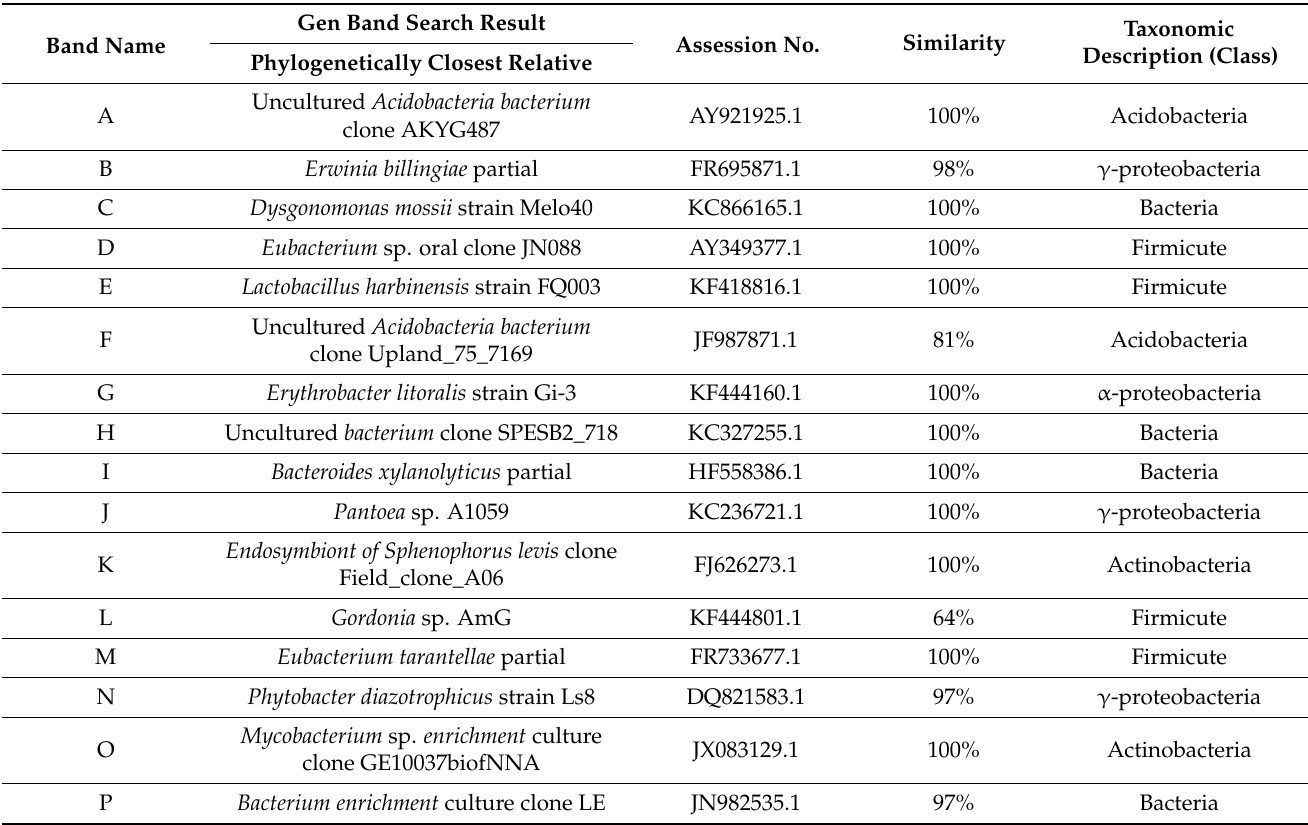
Table 2. Affiliation and similarity of DGGE bands based on 16S rDNA